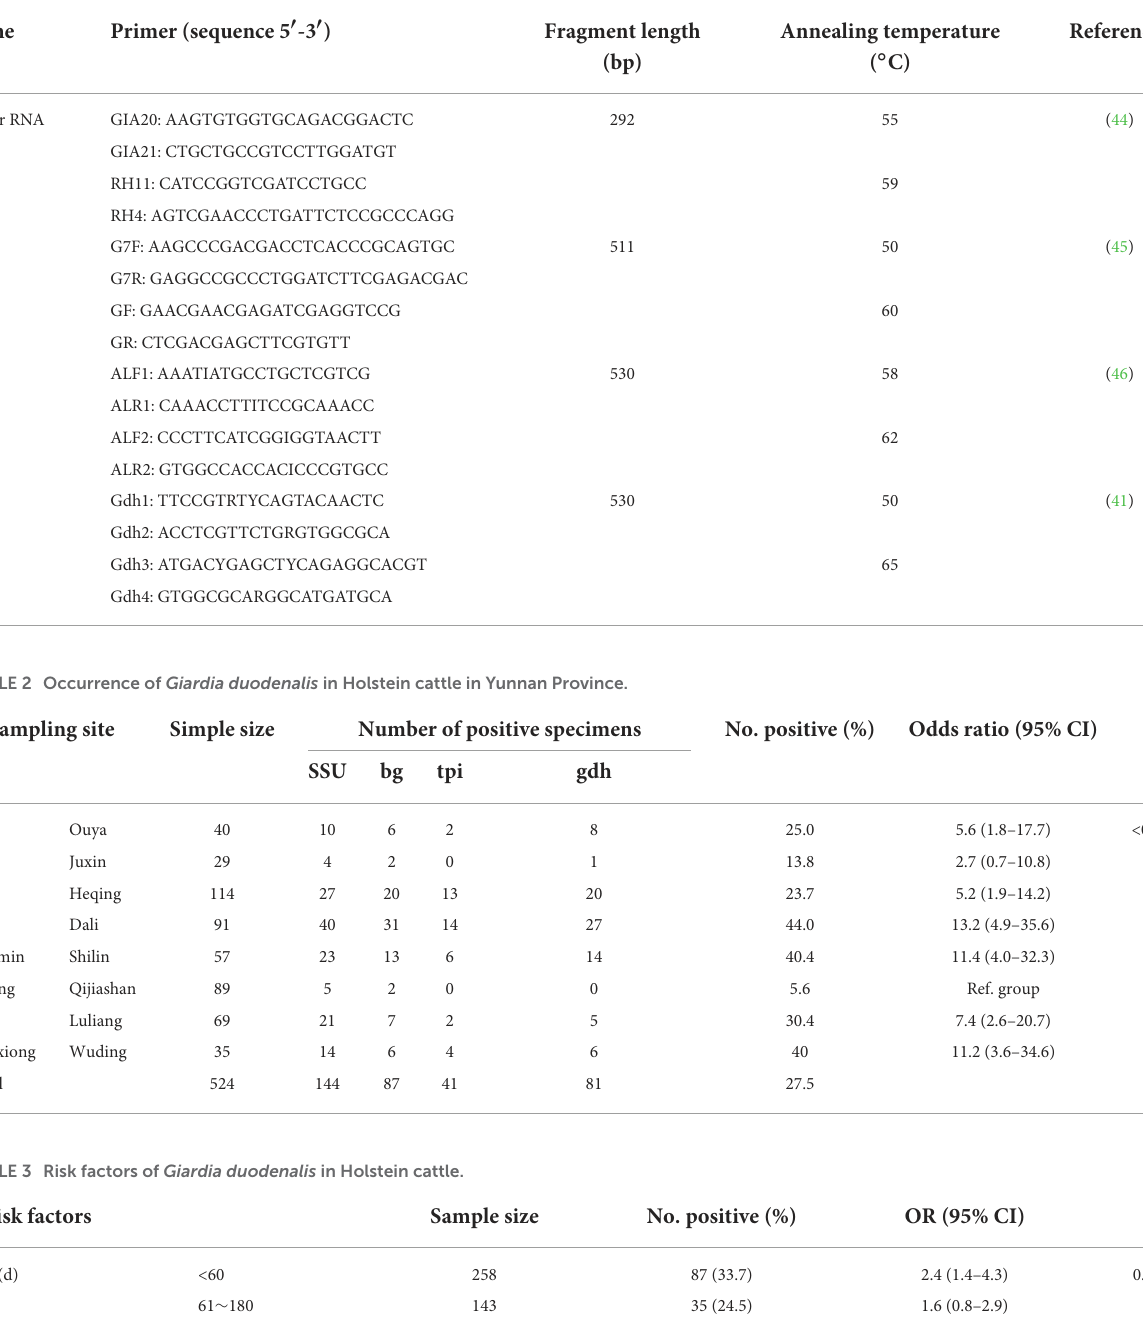
TABLE 1 Primers and expected amplicon sizes for PCR detection and amplification.